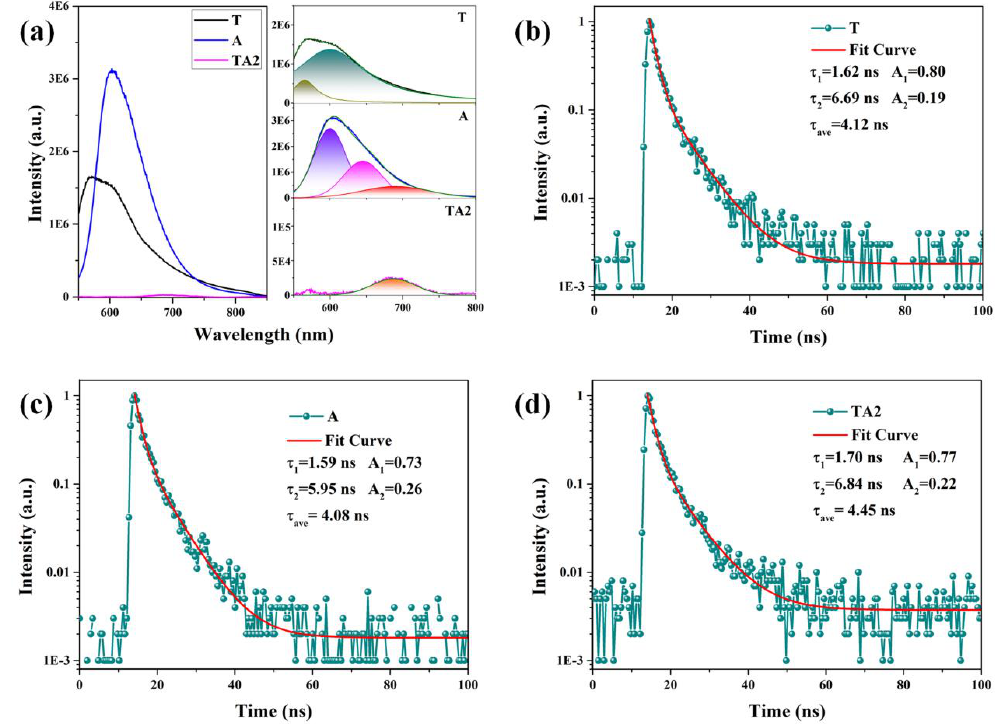
Figure 10. ( a ) PL spectra and fitted peaks of the T, A and TA2 samples, ( b – d ) TRPL spectra of the T, A, and TA2 samples, respectively.